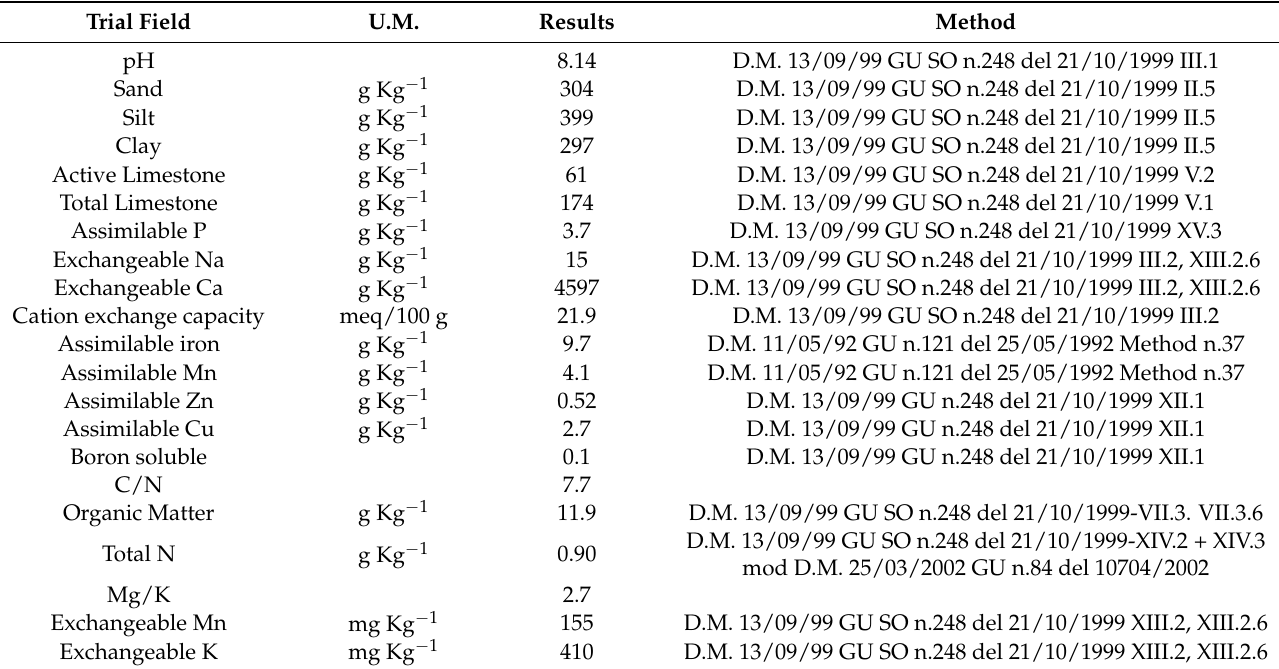
Table 1. Soil characteristics of the experimental field (Assam laboratory). Legend: U.M., unit of measurement.